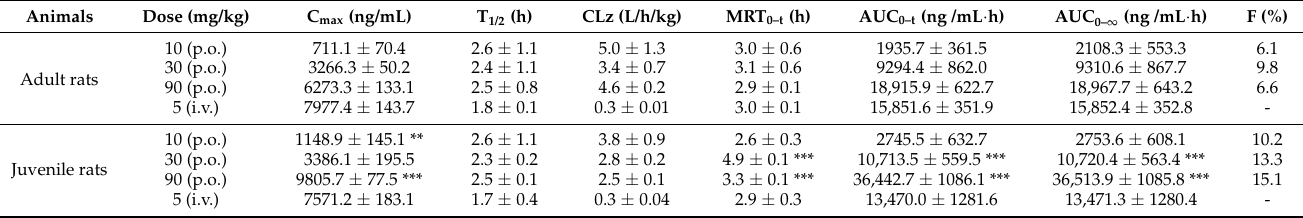
Table 4. Pharmacokinetic (PK) parameters of